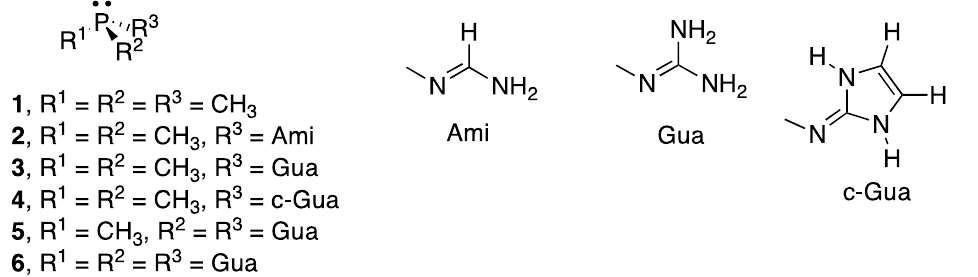
Figure 2. Schematic representation of the phosphines studied.